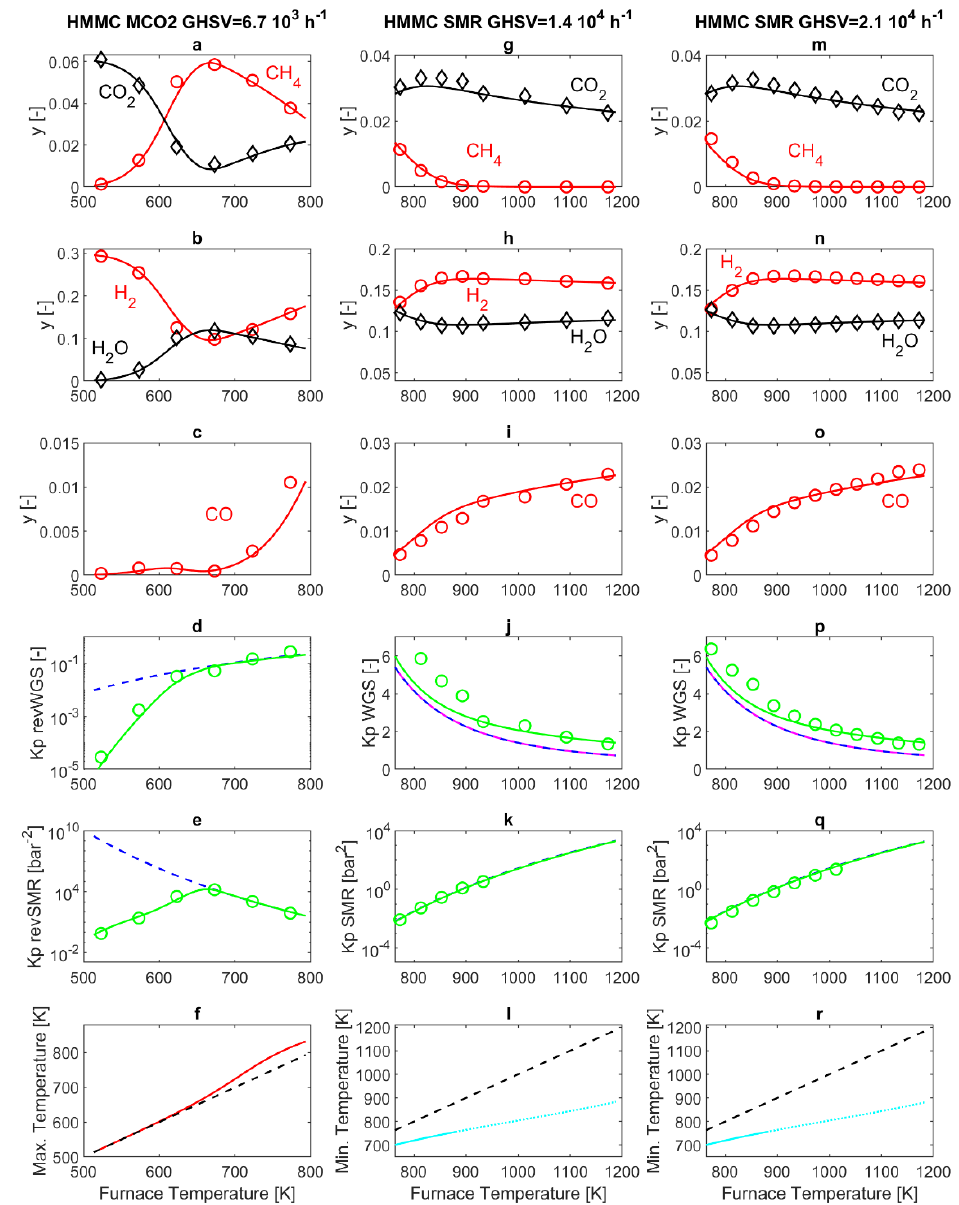
Figure 2. Results for the HMMC catalyst. (Panels a – f ): MCO2 operating mode (GHSV = 6.7 × 10 3 h − 1 ). (Panels g – l ): SMR operating mode (GHSV = 1.4 × 10 4 h − 1 ). (Panels m – r ): SMR operating mode (GHSV = 2.1 × 10 4 h − 1 ). Symbols: experimental data. Lines: simulations. (Panels a – c , g – i , m – o ): compositions at the sampling point (exit of P-R2). (Panels d , j , p ): ━ ━ ━ Kp, WGS calculated at the furnace